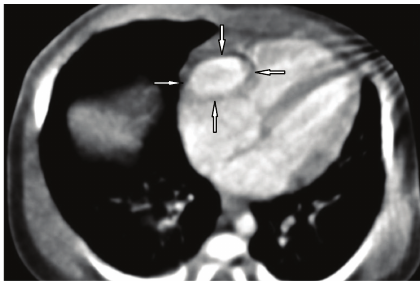
Figure 4: A large aneurysm of the right atrial appendage, measured in cardiac CT (marked with